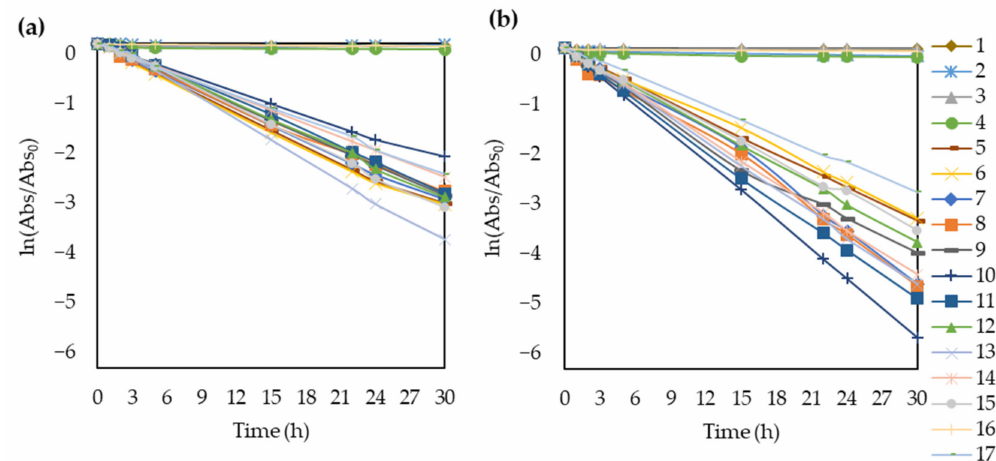
Figure 6. Apparent rate constant calculation plotting the ln(Abs/Abs 0 ) of methyl orange as a function of time under ( a ) natural pH and ( b ) acidic (pH = 3)